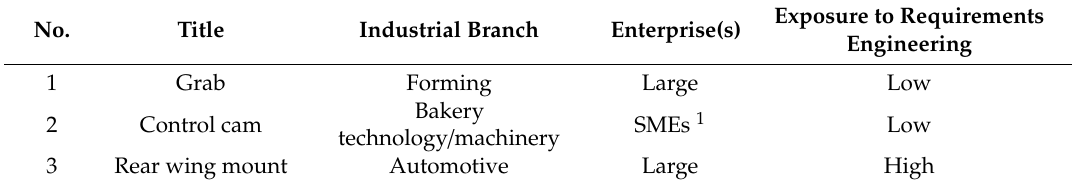
Table 1. Case study